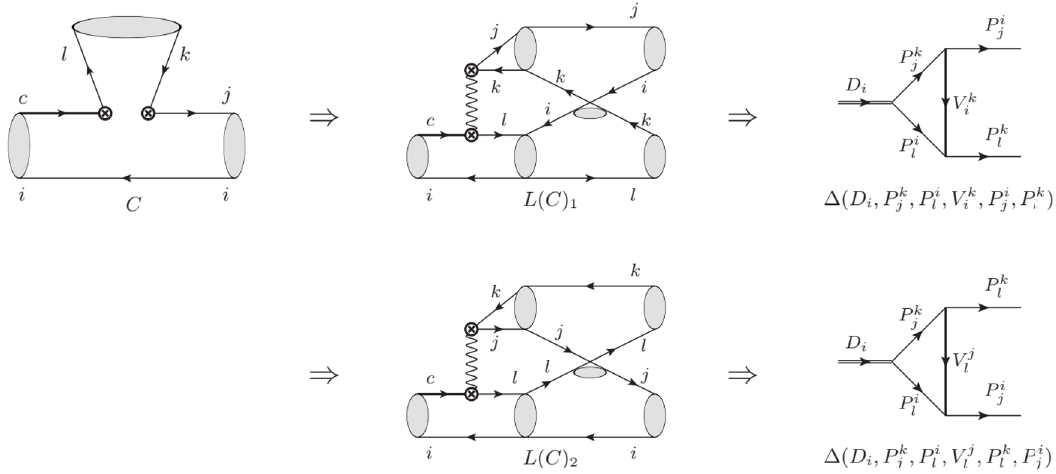
Figure 5 . Topological diagram ⇒ Topological-scattering diagram ⇒ Triangle diagram in T ⇒ C transition.